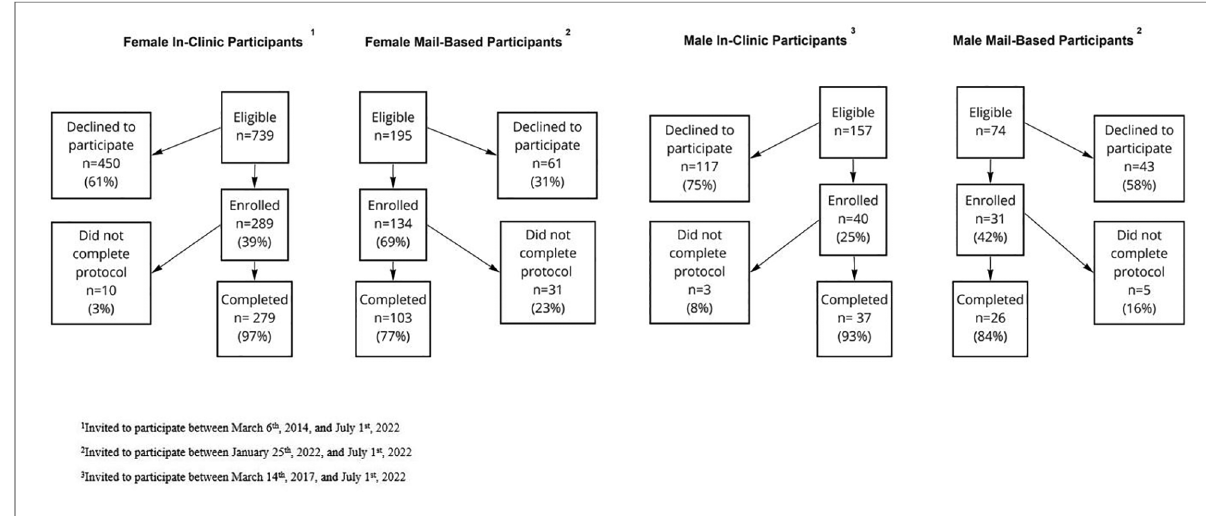
FIGURE 2 Flowchart of exclusions for participants in the mail-based and in-clinic E-PRESTO sub-studies.